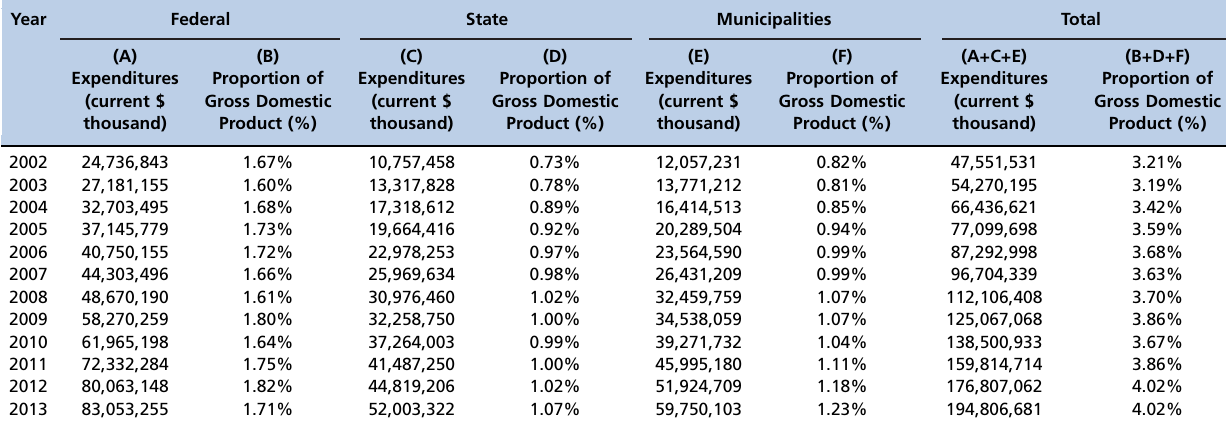
Table 1 - Cost of federal, state, Federal District and municipalities with actions of public health services, by level of government, in current values and percentage share, during the period from 2002 to 2013. Amounts in thousands of Real